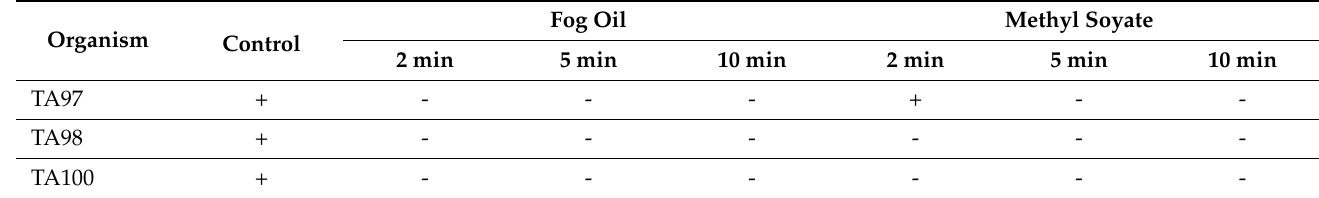
Table 4. Exposure results of plates covered with Kimwipe ® with a center